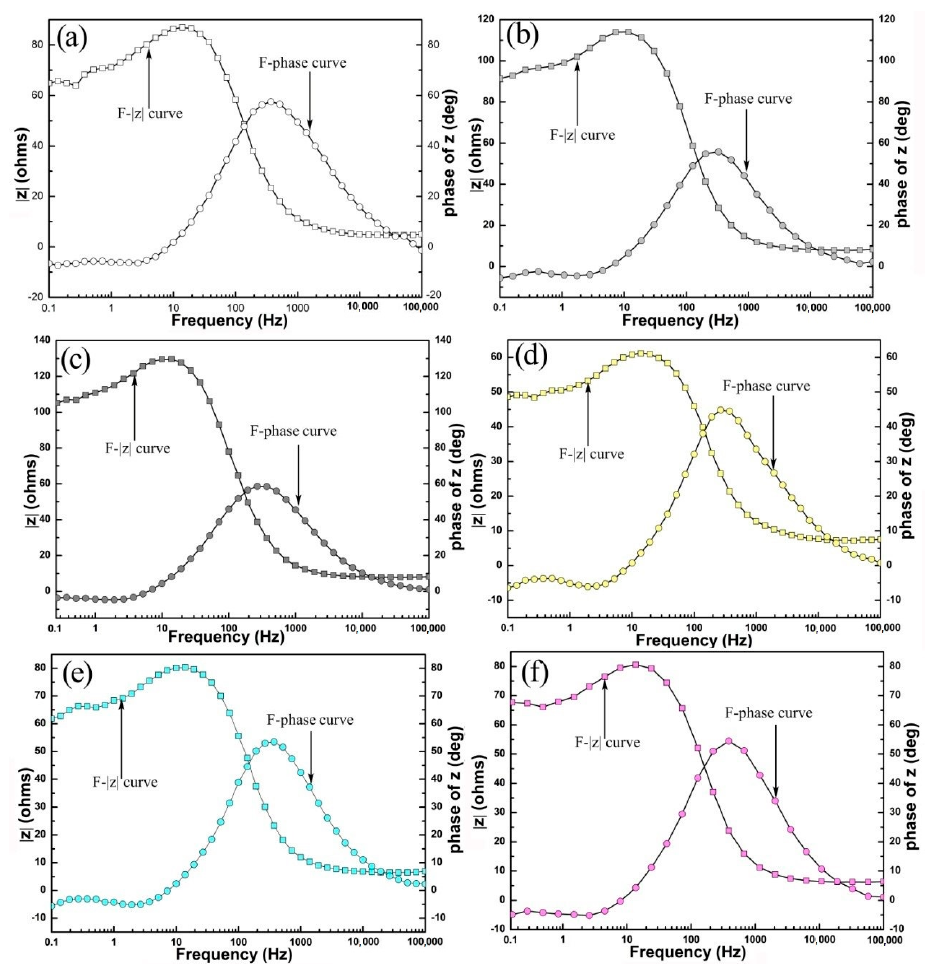
Figure 12. Bode diagrams of different Mg-7Y-1.5Nd samples in 3.5% NaCl at 25 ± 1 °C: ( a ) T4-air quenching; ( b ) T4-water quenching; ( c ) T4-cryogenic quenching; ( d ) T6-air quenching; ( e ) T6-water quenching; and ( f ) T6-cryogenic quenching; |z| represents the impedance value.